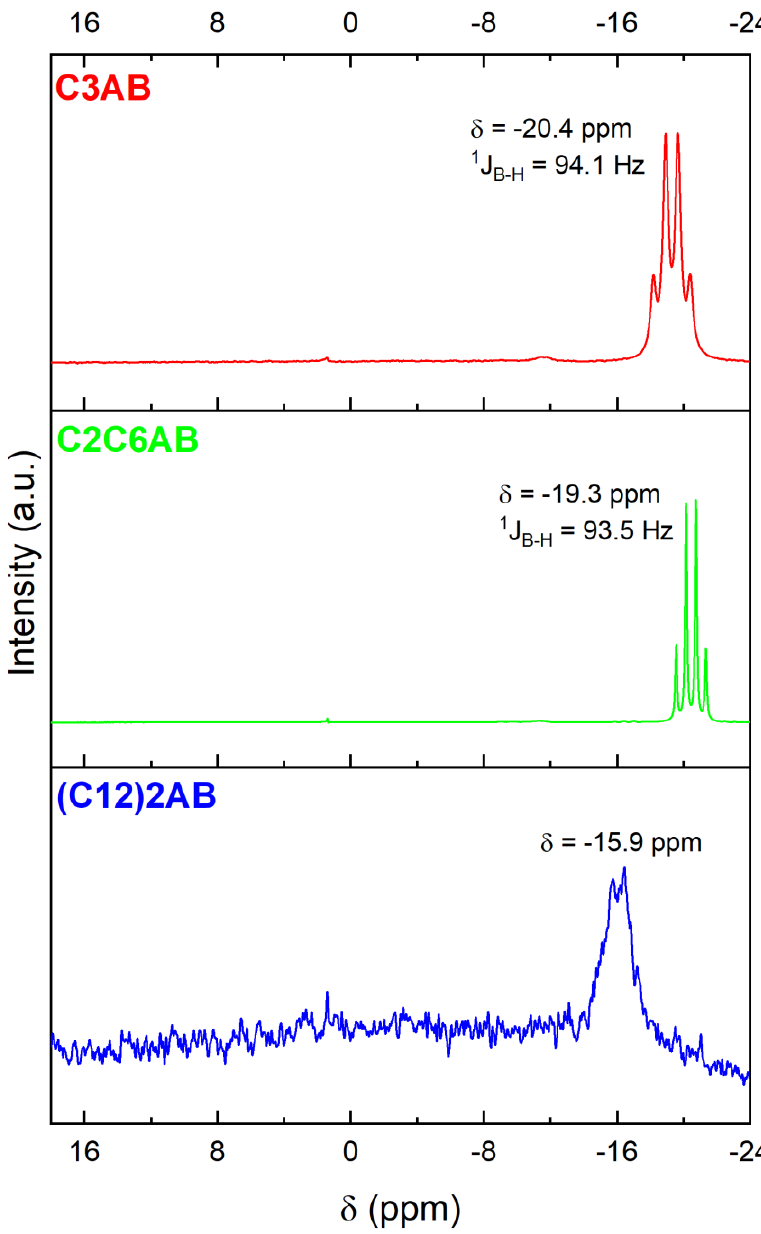
Figure 6. 11 B NMR spectra of C3AB, C2C6AB and (C12)2AB (dissolved in CD 3 CN). The very small signal at 1.4 ppm is due to hydrolysis of the ABAs because of traces of water in CD 3 CN. The very small signal at − 11.5 ppm for C3AB is ascribed XBH 3 (with X = OH − from H 2 O, CH 3 CN from CD 3 CN or (CH 3 ) 2 S) (i.e., the borane used as reactant). The 11 B MAS NMR spectrum of C3AB is typical of the spectrum of an ABA (Figure 7), showing a double-horned peak due to NBH 3 [41]. The signal is centered − 23.5